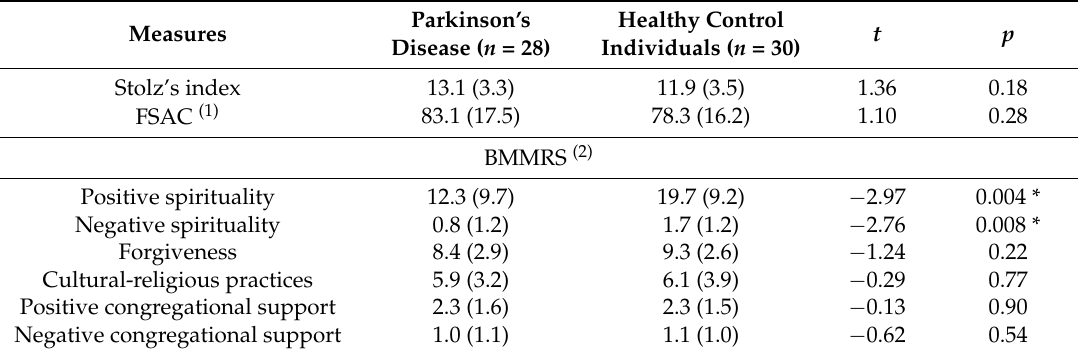
Table 2. Results from the self-report measures of religiosity and